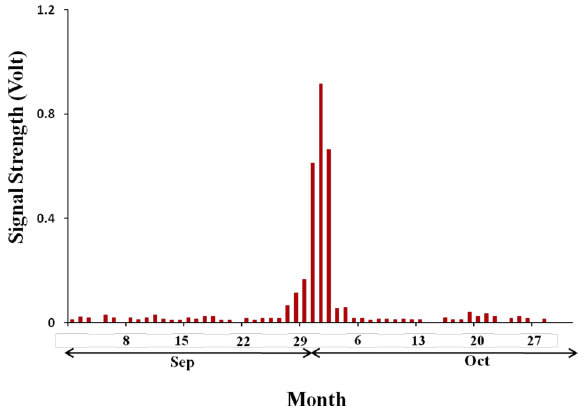
Figure 9. Signal strength (volts) received at GU, from the Chukha FM transmitter for the period September 2012 to October 2012. Note the sudden appearance of the signal from September 28, reaching peak on October 1, 2012 (marked by black arrow head).